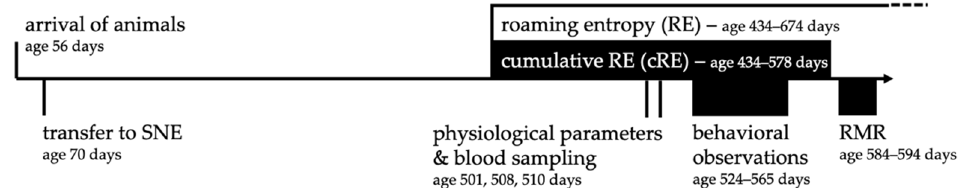
Figure 2. Schematic timeline of the housing of the experimental animals and the different experiments done.